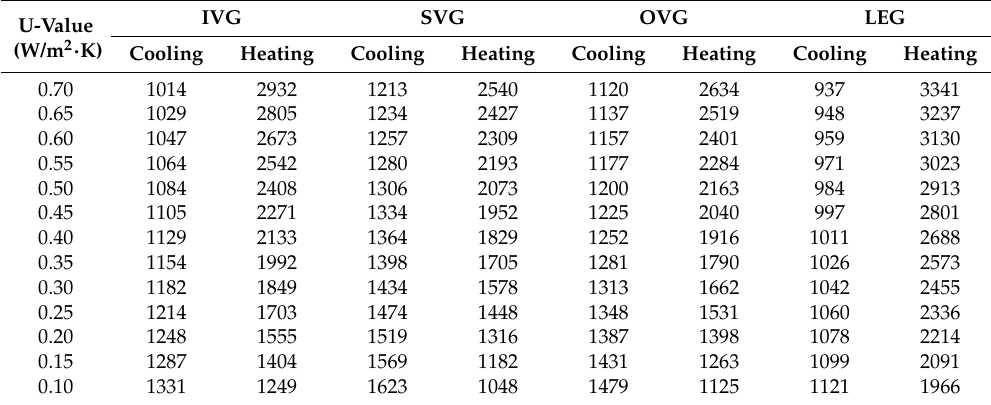
Table 7. Cooling and heating energy due to insulation enhancement in residential buildings